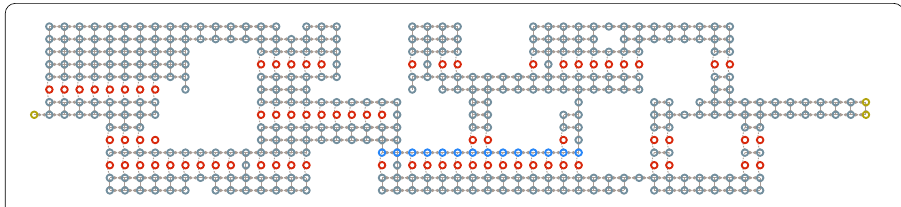
Figure 3 Network representation of the ledge area. It is possible to go from a node to the ones surrounding it using the commands up , right , down and left . The only exception are the red nodes which are ledges. If the character tries to step on one of those nodes it will be automatically sent to the node right below it, characteristic that is represented by the curved links connecting nodes above and below ledges. Yellow nodes mark the entrance and exit of the area and blue nodes highlight the most difficult part of the path. Note that as the original map was composed by squared tiles this network representation is not an approximation but the exact shape of the